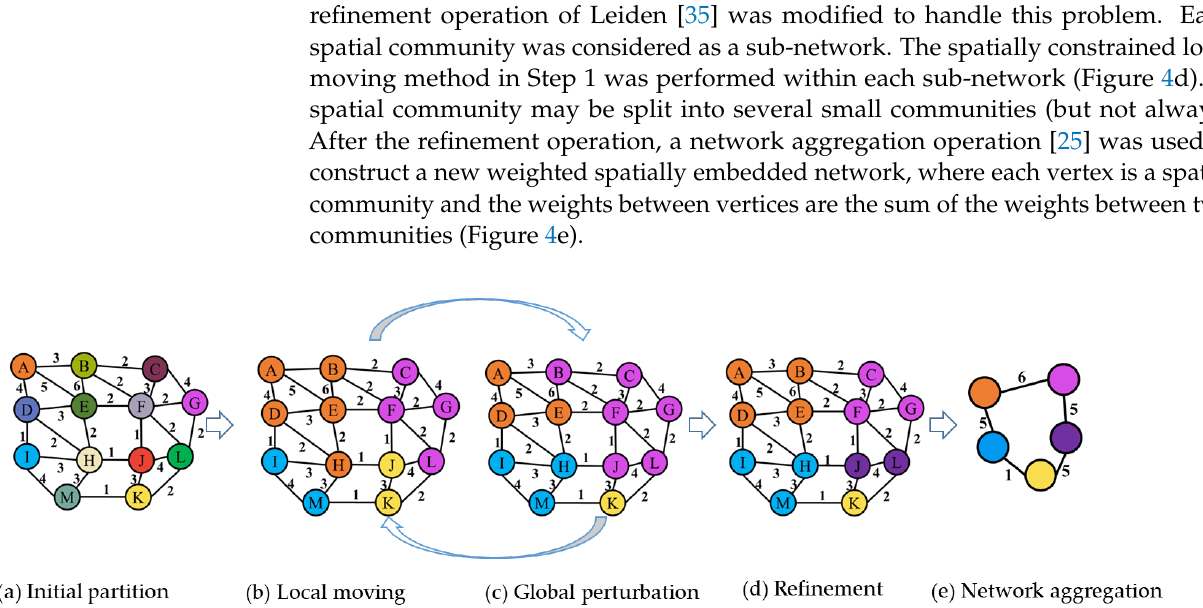
Figure 4. Schematic illustration of the iterative local moving and global perturbation approach: ( a ) initial partition; ( b ) local moving; ( c ) global perturbation; ( d ) refinement; ( e ) network aggregation.